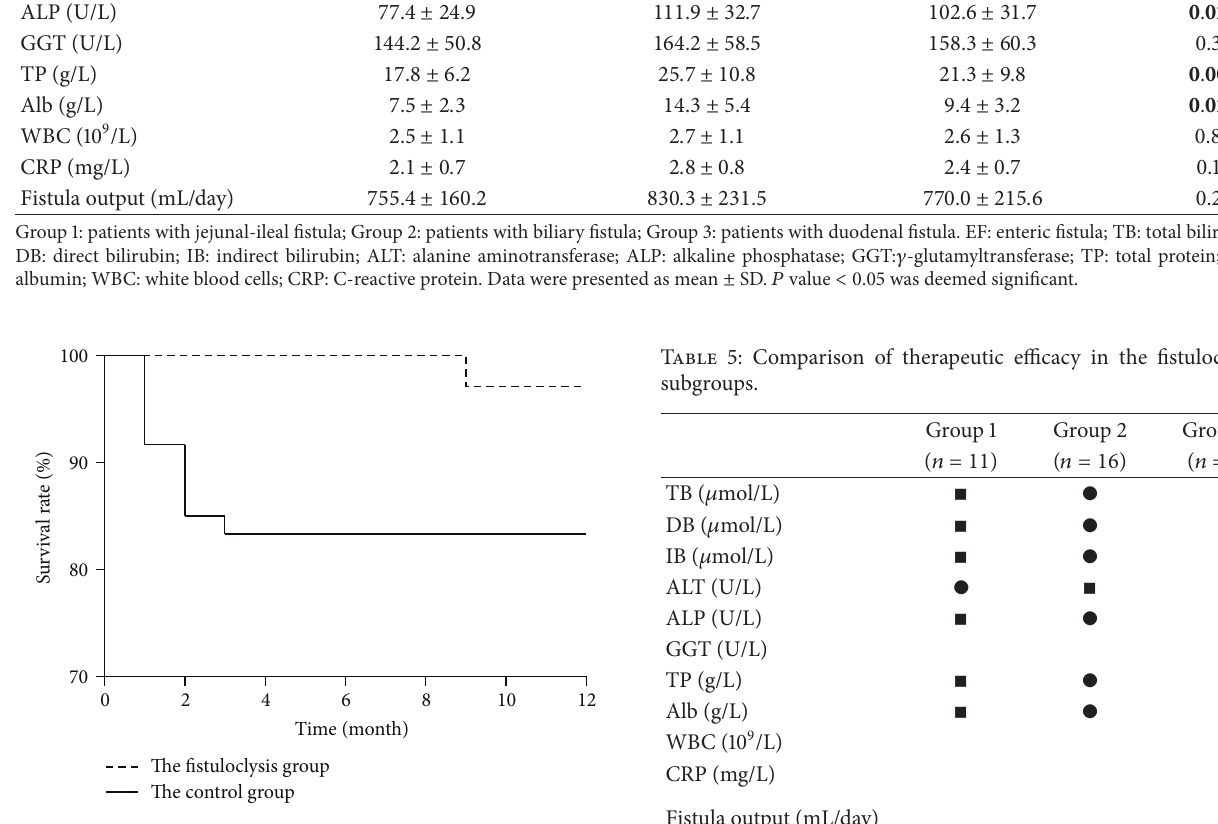
Figure 2: Kaplan-Meier analysis of one-year survival rate and survival time. During the one-year followup, one patient (2.9%) in the fistuloclysis group died, whereas ten patients (16.7%) in the control group died. The numbers of patients remaining in each group are shown in parentheses. The Log-rank test demonstrated the superiority of fistuloclysis compared with the control group ( 𝑃 = 0.045 ).